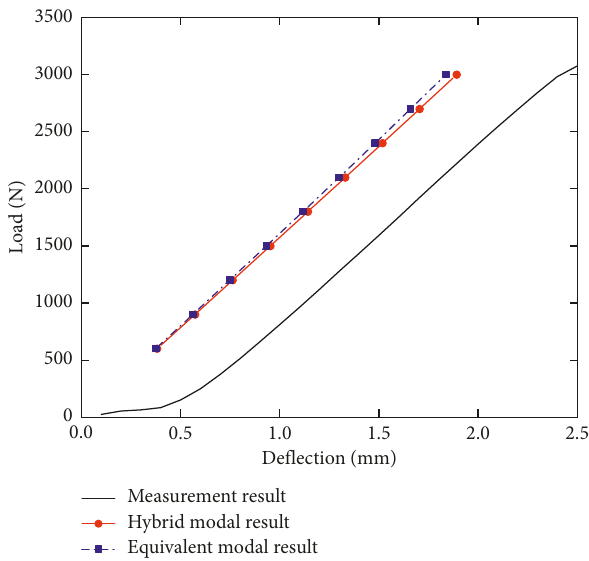
Figure 8: Comparison of the bending property of the floor models and test result.